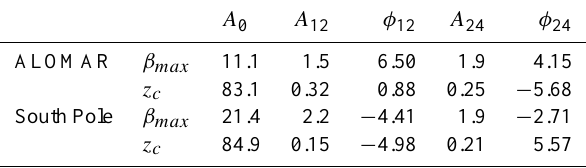
Table 1. Mean diurnal and semidiurnal components of NLC alti- tude [km] and brightness [10 − 10 m − 1 sr − 1 ] above ALOMAR and the South Pole (Chu et al., 2003). The data sets contain 7 NLC sea- sons at ALOMAR and 2 seasons at the South Pole. Phases refer to minimum absolute values and are given in LT and UT hours for ALOMAR and the South Pole, respectively. The brightness ampli- tudes for the South Pole data are converted (see